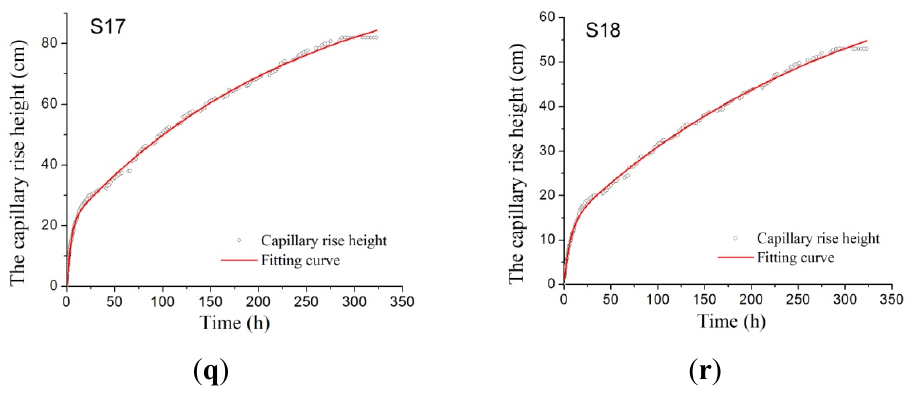
Figure 8. Capillary rise of 18 major soil types in the Sanjiang Plain, Northeast China. ( a ) S1;